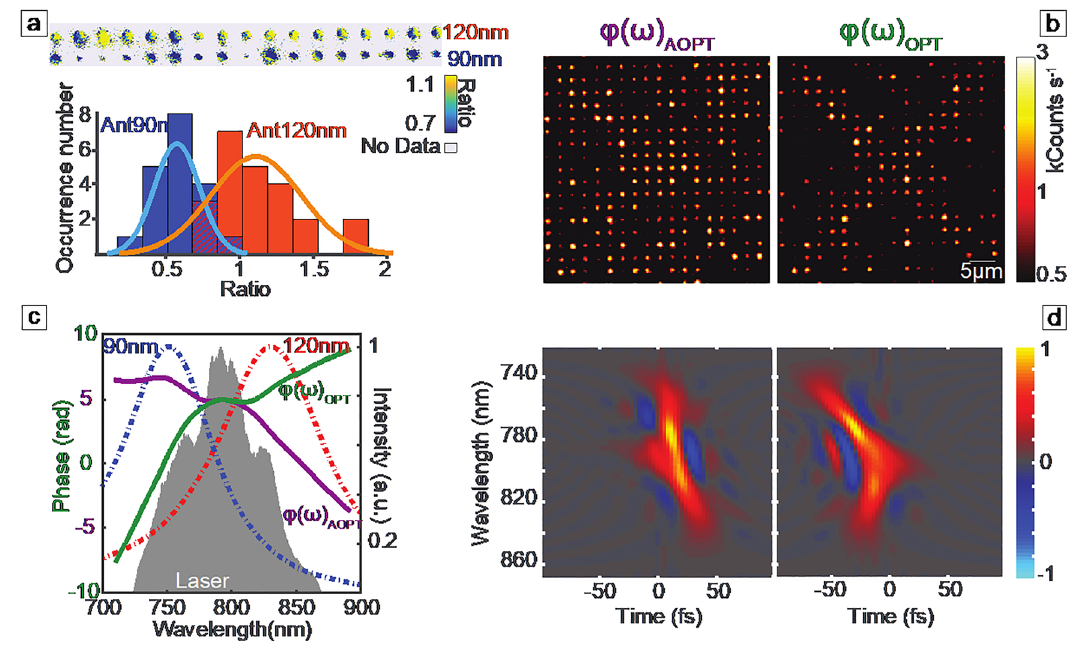
Figure 3: Coherent control of nanoantenna arrays. (a) The upper image is the ratio between the TPPL images of an array of nanoantenna pairs obtained with φ ( ω ) OPT and φ ( ω ) AOPT , respectively. Nanoantennas of 120nm arebrighter whenusing φ ( ω ) OPT , whereasthe 90 nmonesare brighterwhen excitedwith φ ( ω ) AOPT . The histogramon the bottom quantitatively analyses the ratio of all the 90 nm antennas and 120 nm nanoantennas with the two different phases. The cyan and orange curves superimposed on the histogram are fi ts to the data assuming a normal distribution. Note that, in the histogram, a full array of nanoantennas is considered for the statistics (23 pairs), whereas in the upper image, a zoom on 17 pairs of nanoantennas is shown. We also note that for some of the 90 nm antennas, the TPPL intensity emitted with φ ( ω ) OPT is so low that it is not taken into account in the histogram graph. (b) Two-photon – induced photoluminescence images of an array of mixed 120 and 90 nm antennas using φ ( ω ) AOPT or φ ( ω ) OPT . The encoded message clearly appears when using φ ( ω ) OPT and is erased by φ ( ω ) AOPT . (c) Laser spectrum (shaded region), φ ( ω ) OPT (green curve) and φ ( ω ) AOPT (violet curve) as measured with the multiphoton intrapulse interference phase scan (see Methods). The red and blue dashed curves are the resonance response of the 90 nm and the 120 nm nanoantennas as obtained by Finite-Difference Time-Domain (FDTD) simulations. (d) Time – frequency Wigner representation of the pulses corresponding to the optimization (right) and antioptimization (left) case. TPPL, two-photon – induced This difference could be due to distinct coherence time procedure as for Figure 2f) of one array of paired 90 and for the two antenna species, as explained below. 120 nm nanoantennas, obtained under excitation with φ ( ω ) Now, we can use this coherent selectivity in nonlinear and φ ( ω ) . From this image, one can see that OPT AOPT microscopy, as shown for ensembles of molecules and changing from φ ( ω ) to φ ( ω ) produced the same OPT AOPT quantum dots [53 – 56], and extend the control to the fi eld of overall effect in most of the 90 – 120 nm nanoantenna nanoplasmonics. Figure 3b demonstrates this concept at pairs. Statistical analysis is given in the histogram of the level of individual nanoantennas. We fabricated an Figure 3a, which helps visualizing this trend. The dis- array of mixed 120 and 90 nm nanoantennas. The 120 nm tribution of the ratios is clearly shifted, as con fi rmed by fi ts to the data presented in the histogram assuming a nanoantennas were arranged such to form an encoded message, in this case the letter ‘ X ’ , on a background of normal distribution function. The width of the distribu- 90 nm ones. We acquired two different two-dimensional tions is caused by the intrinsic variability of fabrication, TPPL images of such array using φ ( ω ) which is always present for e-beam nanofabricated an- and φ ( ω ) , OPT AOPT tennas. It must also be noted that a higher level of con- respectively. As Figure 3b demonstrates, by using pure trol could be obtained for the 90 nm nanoantennas. By coherent control, we could deterministically reveal or changing the spectral phase from φ ( ω ) completely hide the encoded message. In this case, com- to φ ( ω ) , AOPT OPT plete switch of the TPPL maximum from 120 to 90 nm the TPPL from the 120 nm nanoantennas increased on average by ∼ 1.12, whereas that from 90 nm nano- f) as the 120 nm ones always emitted more TPPL. Still, clear antennas decreased by ∼ 1.76, with a total contrast of ∼ 2.